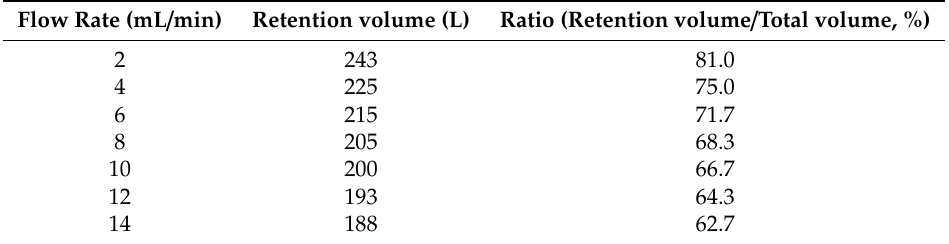
Table 2. The retention volume of the upper phase at di ff erent flow rates.